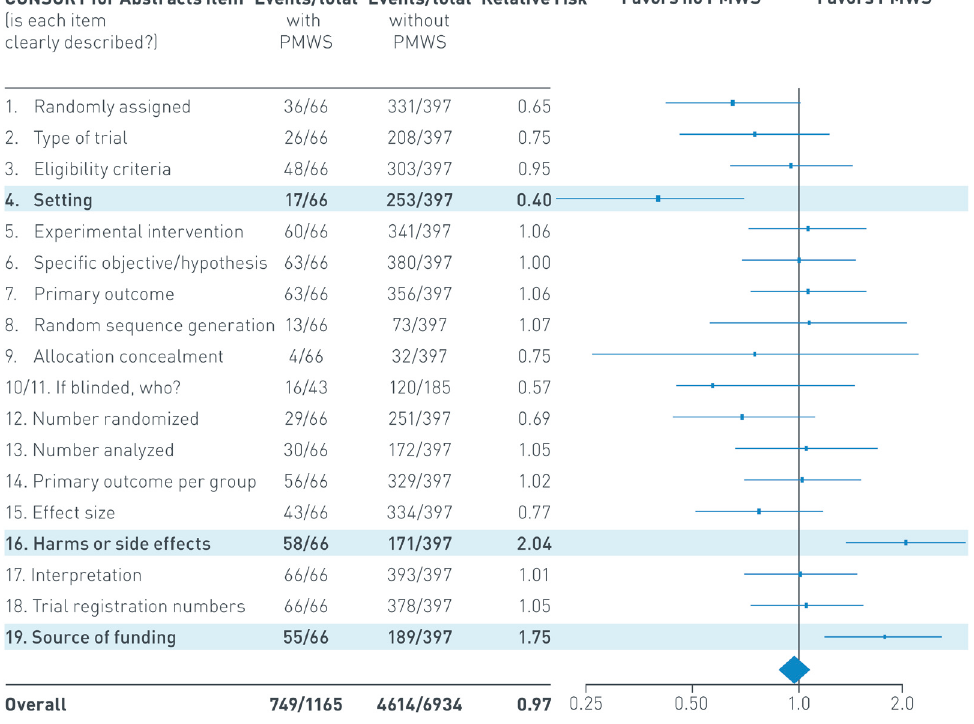
setting (item 4) was 0.0010, for harms or side effects (item